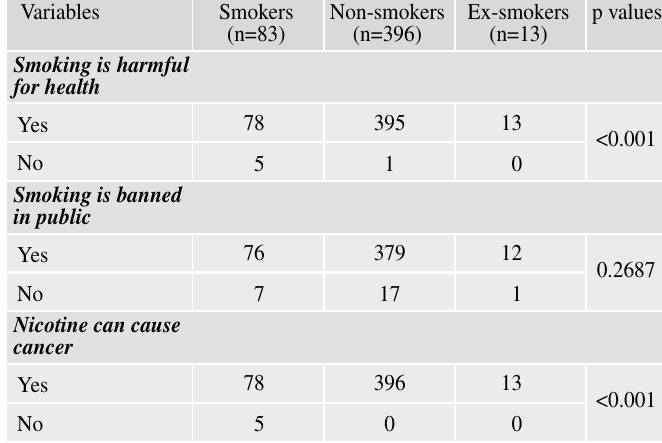
Table VII: Distribution of study subjects according to